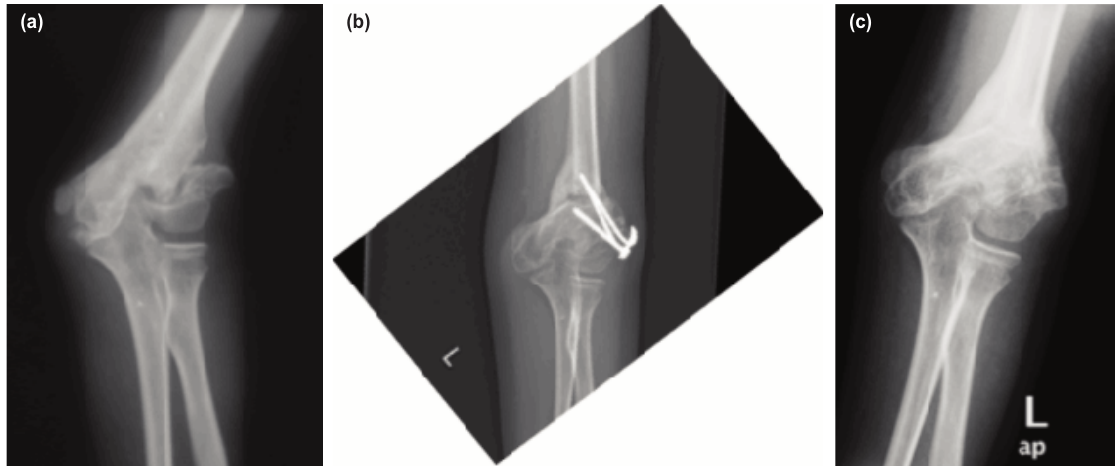
Radiograph of the left elbow. (a) Pre-operative film showing left cubitus valgus with non-union lateral humeral condyle. Fig. 2: (b) Post-operative film after corrective osteotomy in the process of healing two months after surgery. (c) Post-removal of implants after three months.